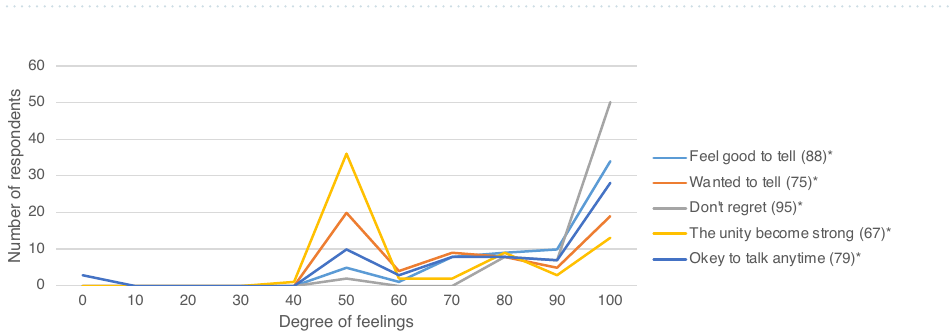
Table 5. Important points when disclosing. Note all items were multiple choice answers. a This number reflects the number of respondents who answered that they had disclosed information to the siblings of affected children in questionnaire I.